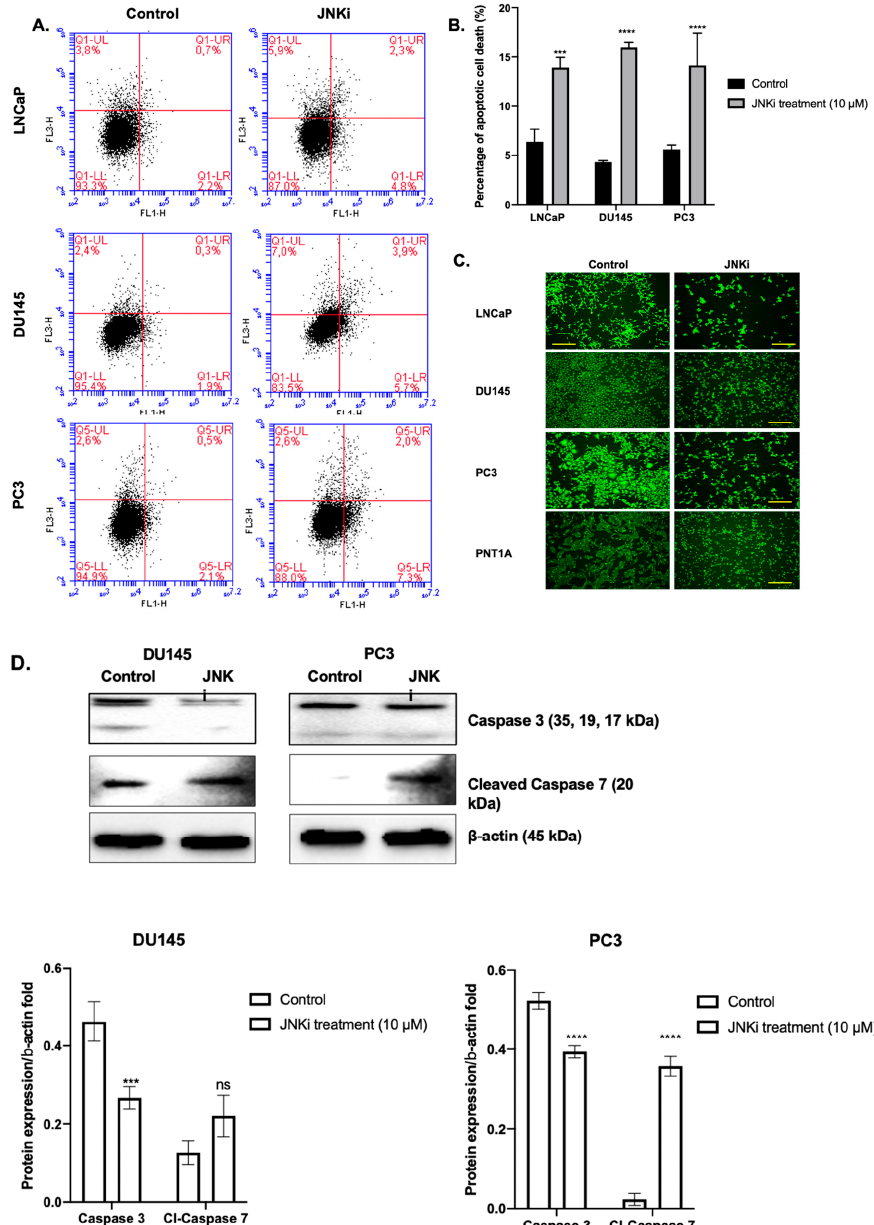
Figure 1. Inhibition of c-Jun N-terminal kinase (JNK) sensitizes LNCaP, DU145, and PC-3 cells